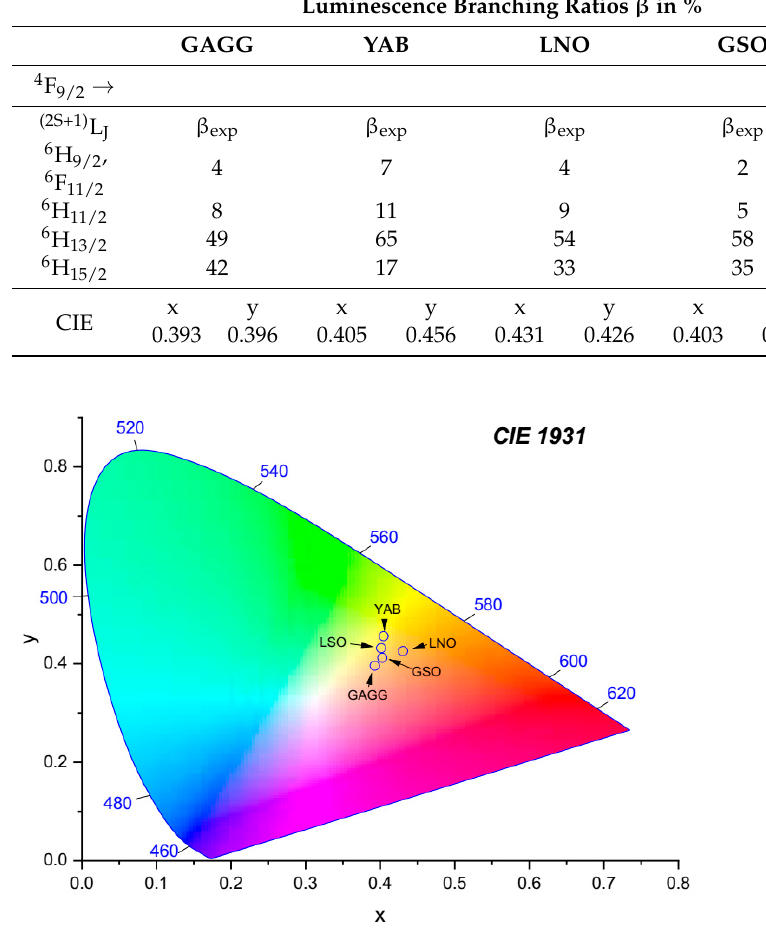
Figure 3. CIE chromacity diagram constructed based on the color coordinates gathered in the bottom of Table 2. Table 2. Experimental luminescence branching ratios β of the Dy 3+ 4 F 9/2 → (2S+1) L J transitions and determined CIE values.